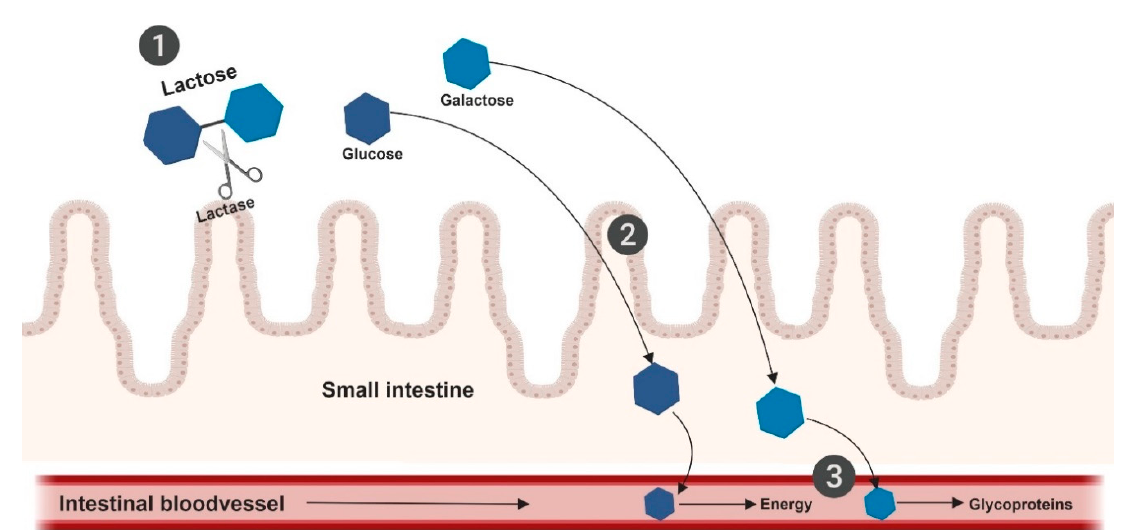
Figure 5. The digestion of lactose in the small intestine. (1) Hydrolyzation of lactose by lactase, located in upper layer of enterocytes. (2) Rapid absorption of monosaccharides, glucose and galactose, which is maximal in the proximal jejunum. (3) Glucose will be used for energy, galactose as a part of glycoproteins. Created with BioRender.